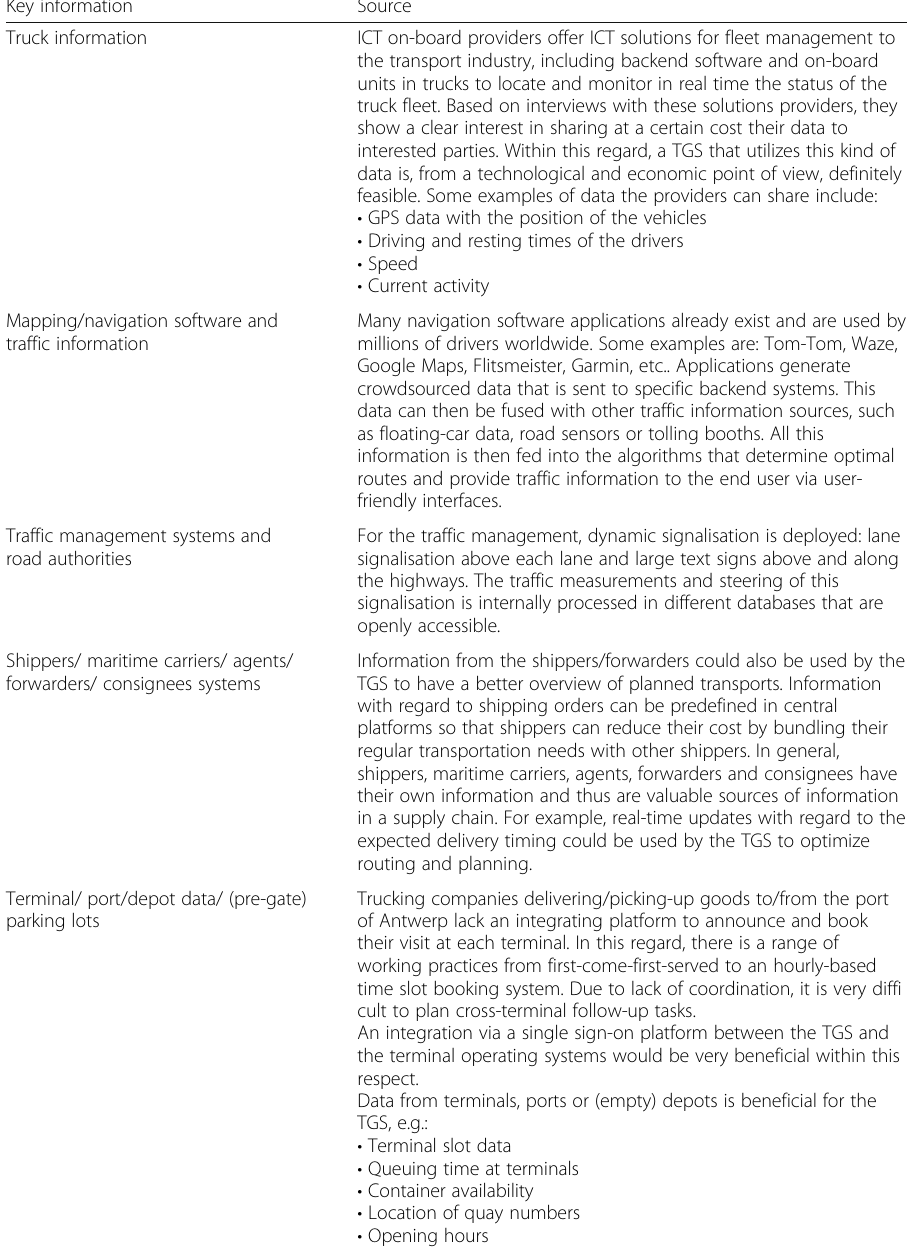
Table 1 Key information sources for a TGS [Source: own composition based on interviews results] Key